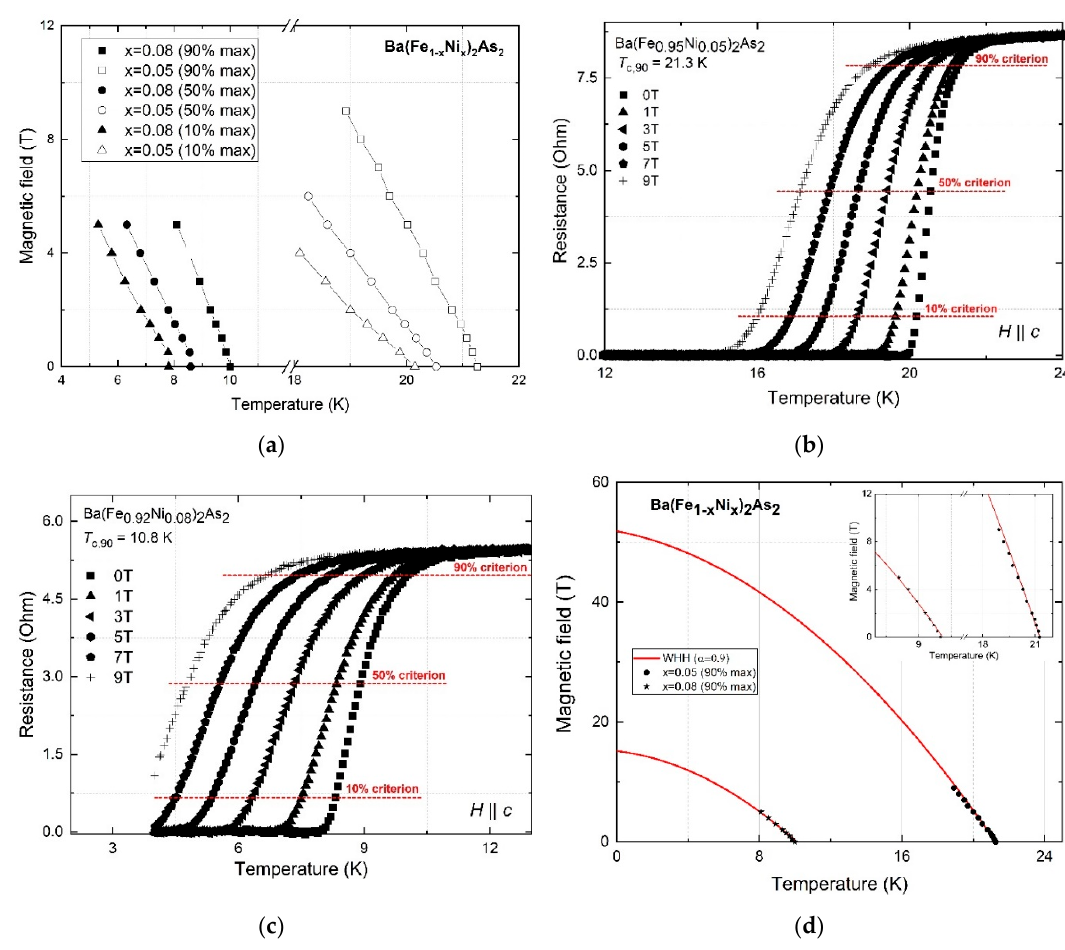
Figure 3. Temperature dependence of the magnetic field ( a ) and resistance in the applied magnetic field ( b,c ), as well as Werthamer–Helfand–Hohenberg (WHH) fitting with paramagnetic effect ( d ) for Ba(Fe 1-x Ni x ) 2 As 2 films with x = 0.05 and 0.08. The complete dataset of the R(T,B) measurements is shown in a previous paper [16].